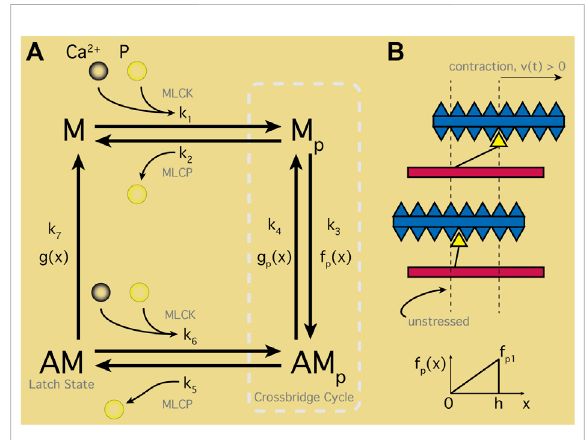
FIGURE 6 Smooth Muscle Contraction Schematic. (A) Four-states representing the myosin head (M) and actin fi lament/myosin complex (AM) in unphosphorylated states. Ca 2+ binds with calmodulin-myosin complexes activating the myosin light- chain kinase (MLCK). MLCK combined with phosphate ( p ) transitions M to Mp, entering the crossbridge cycle with AMp. Transition between Mp and attached AMp states perform contractile work as determined by displacement, x. Rate of attachment in turn dependent on x with maximal and minimal displacements via f(x); detachment transitions similarly with g(x). Latch state — or dephosphorylated AM — classic feature of smooth muscle cells maintaining contracted state without energy input; note, M can only reach the latch state through the crossbridge cycle. (B) Depiction of contracted or unstressed latched states aligned with displacement range (0 ≤ x ≤ h ) and transition rate dependency on displacement illustrated for f ( x ) with maximum rate at full contraction. f(x) and g(x) designed to match Hai & Murphy parameters at the average point x = h